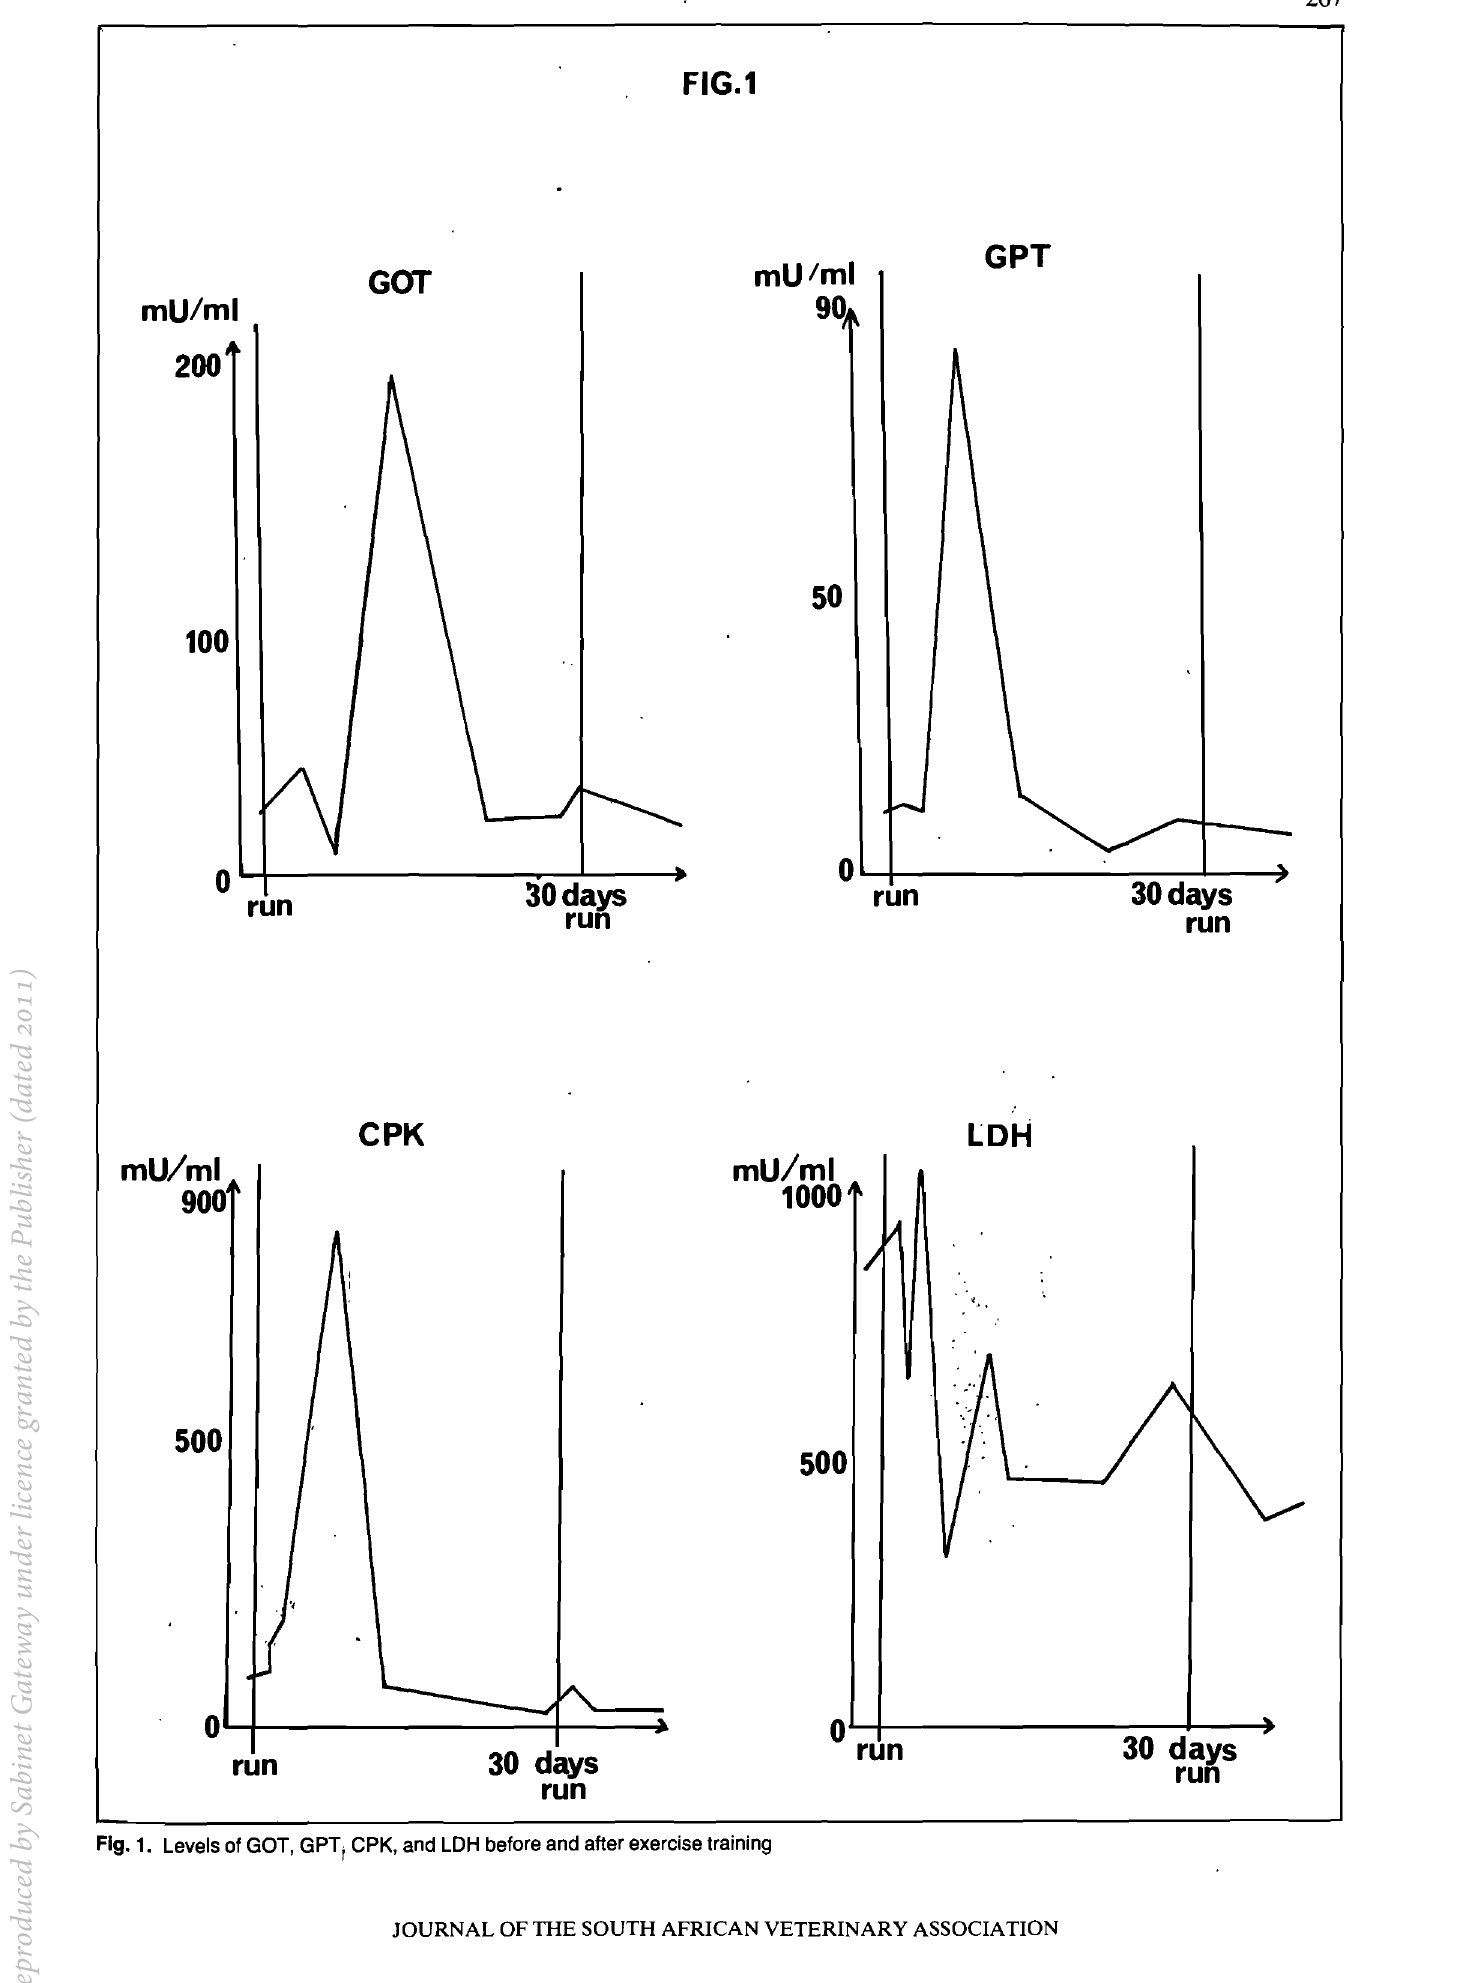
JOURNAL OF THE SOUTH AFRICAN VETERINARY